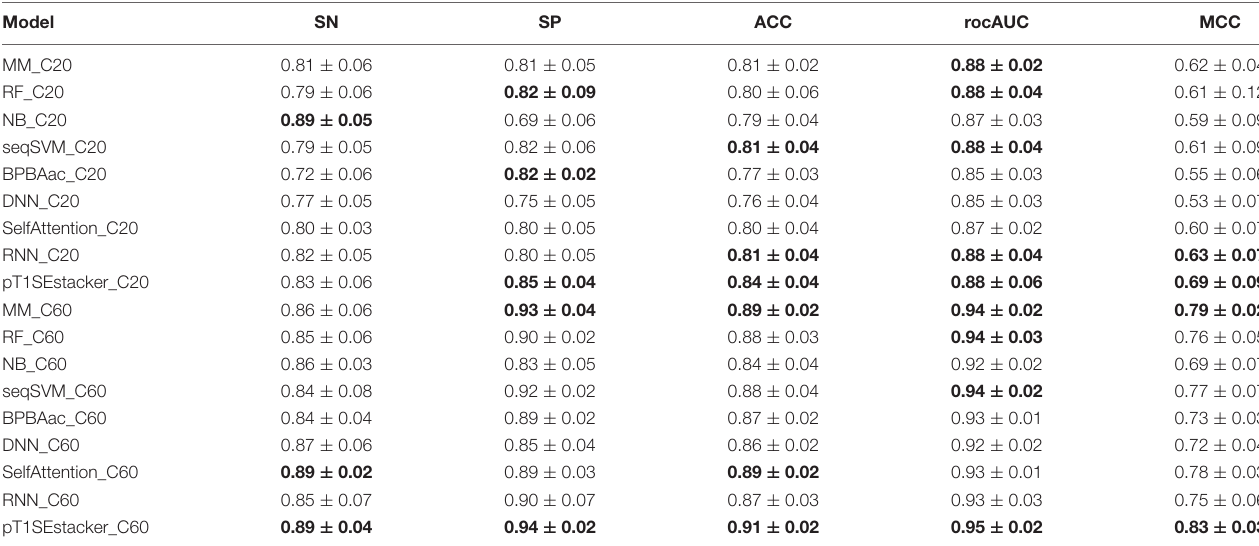
TABLE 2 | Performance of